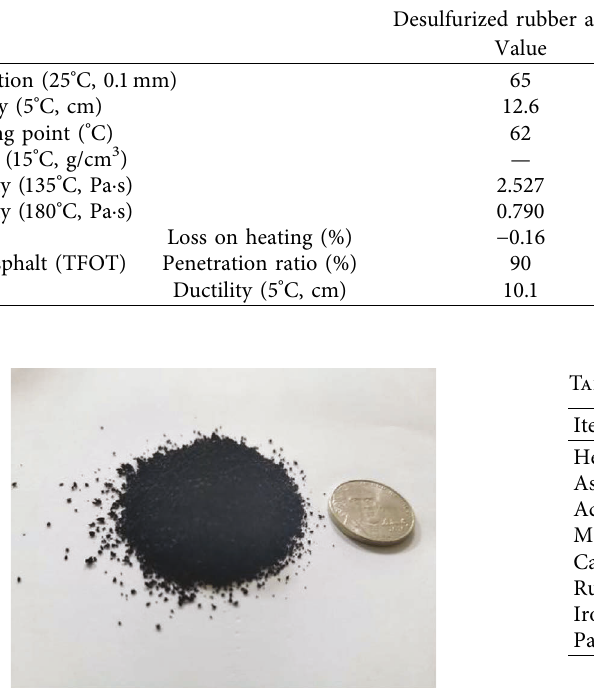
Figure 1: Rubber powder.